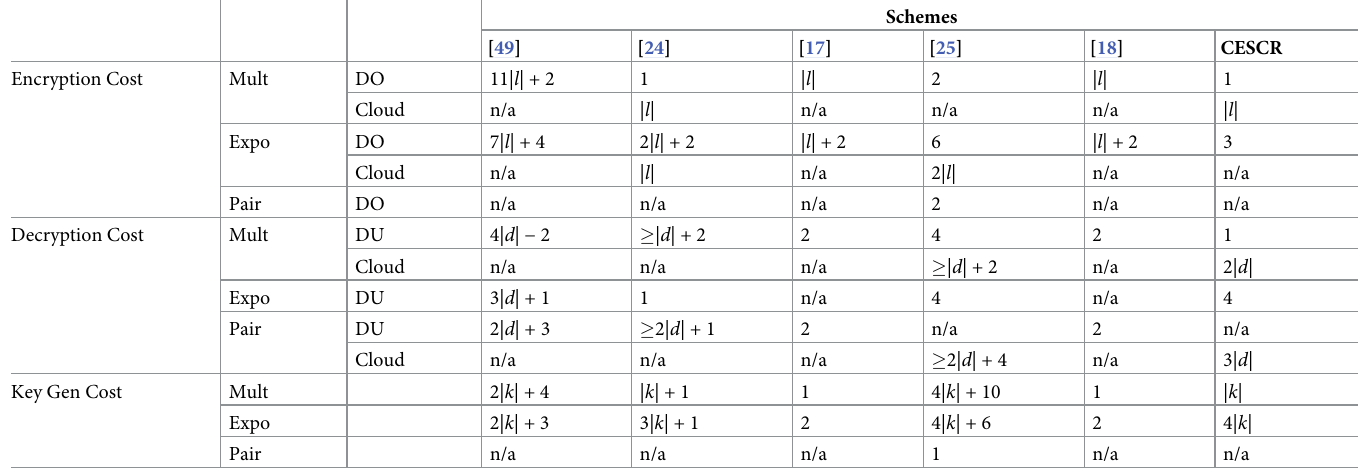
Table 2. Computation comparison of CP-ABE